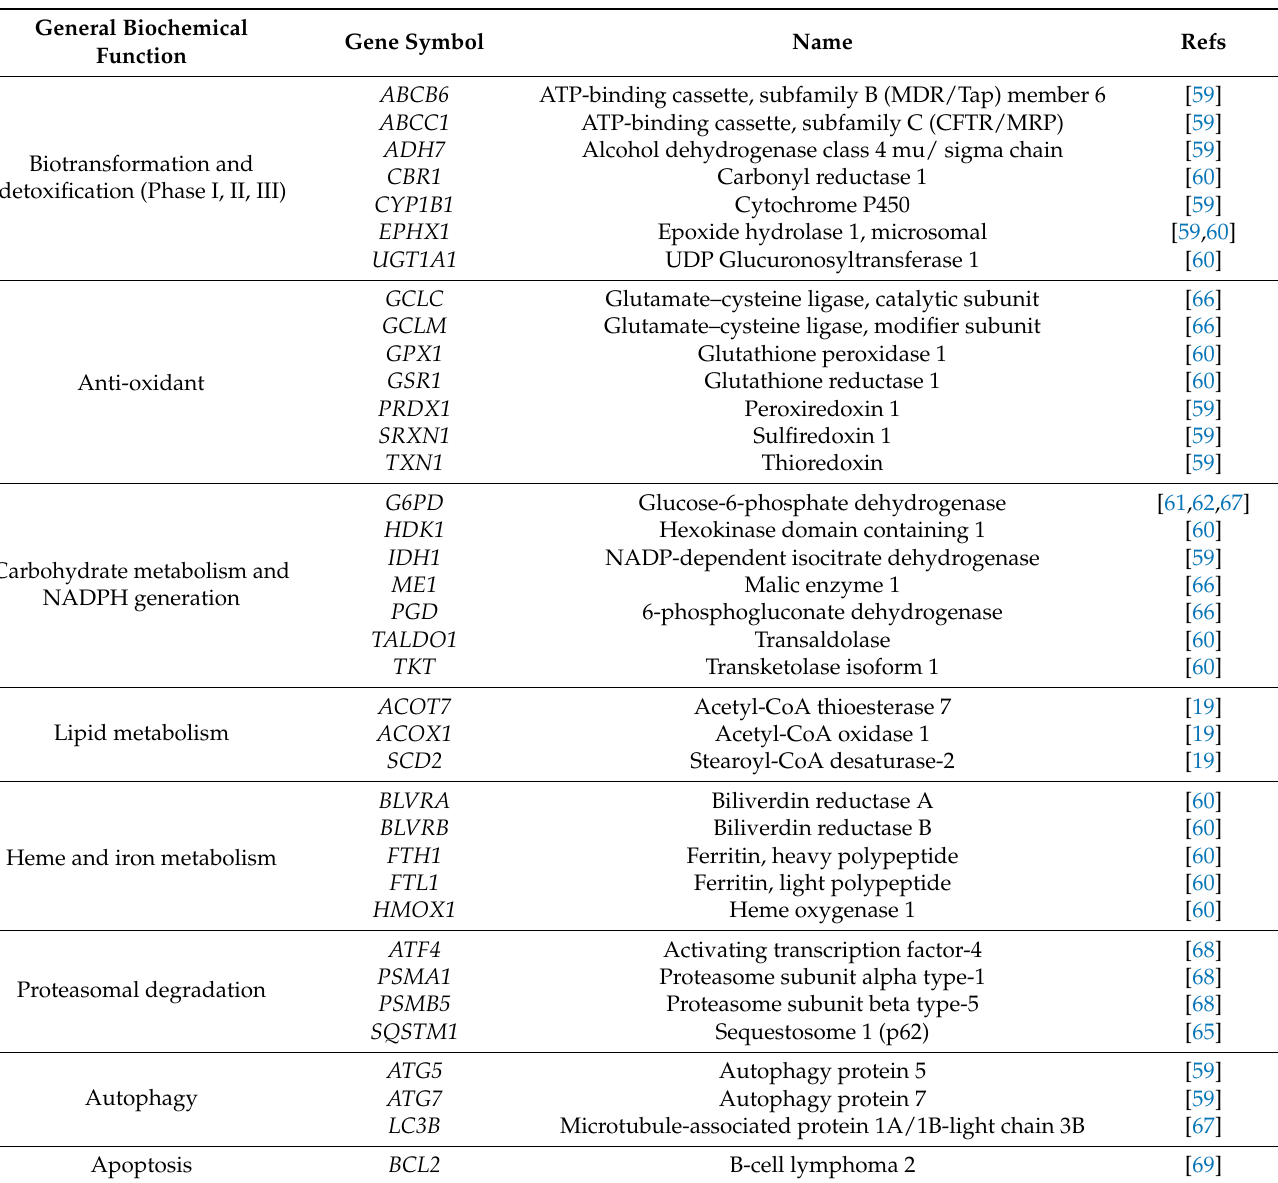
Table 1. A list of genes regulated by